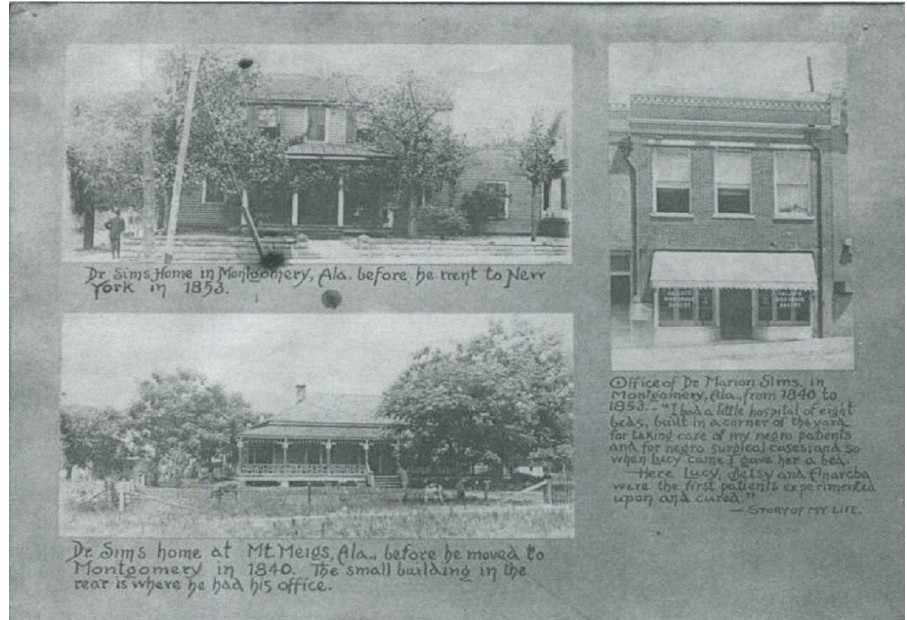
Figure 3. Image Homes of Dr. James Marion Sims in Montgomery and Mount Meigs, Alabama, and his office in Mont- gomery. Photograph is copyright of the Alabama Department of Archives and History, Photographs and Pictures Collec-